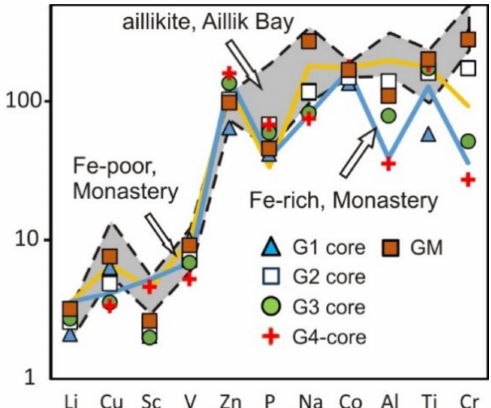
Figure 5. Average trace element composition (ppm) of groundmass olivines and olivine macrocrysts. Legend as in Figure 4. The composition of the central parts of olivine phenocrysts from the aillikites of Aillik Bay (gray field) [24], as well as the average contents of olivines from the Cr-poor megacryst suite from the Monastery kimberlite [46], were provided for